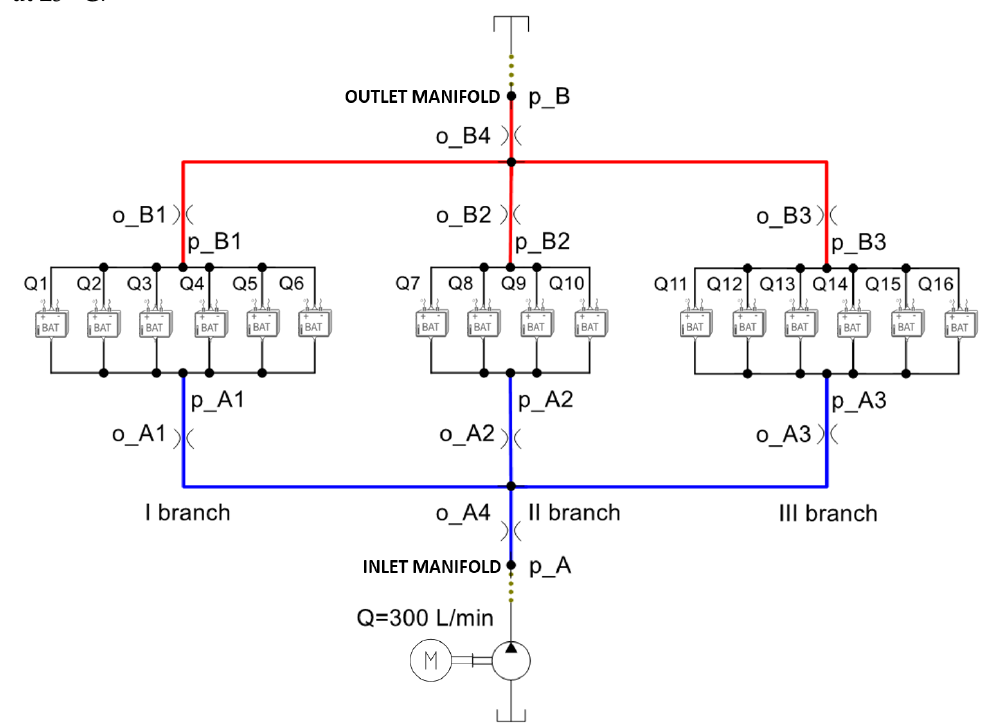
Figure 1. Battery liquid cooling